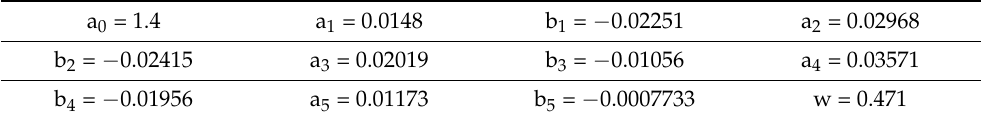
Table 3. The db series wavelet packet base corresponded to the parameter value of the MSE fit- ting function.